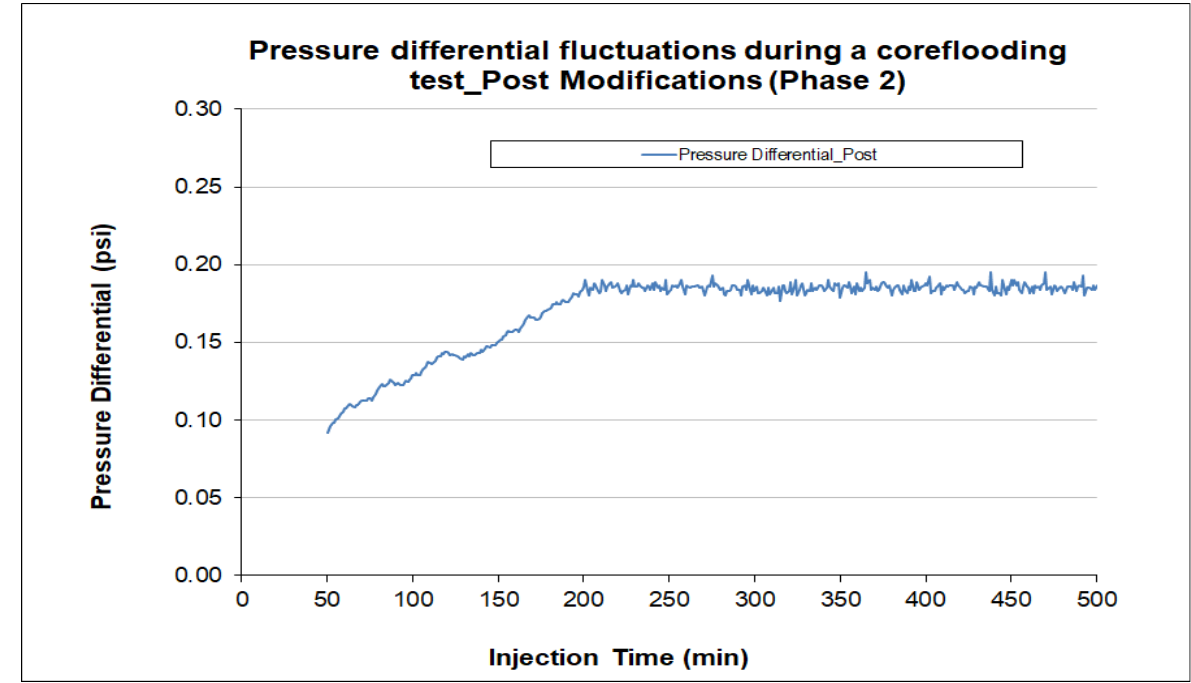
Figure 9: Fluctuations in the pressure differential measurements during a coreflooding test, after making the modifications in the permeameter. Source: Authors,